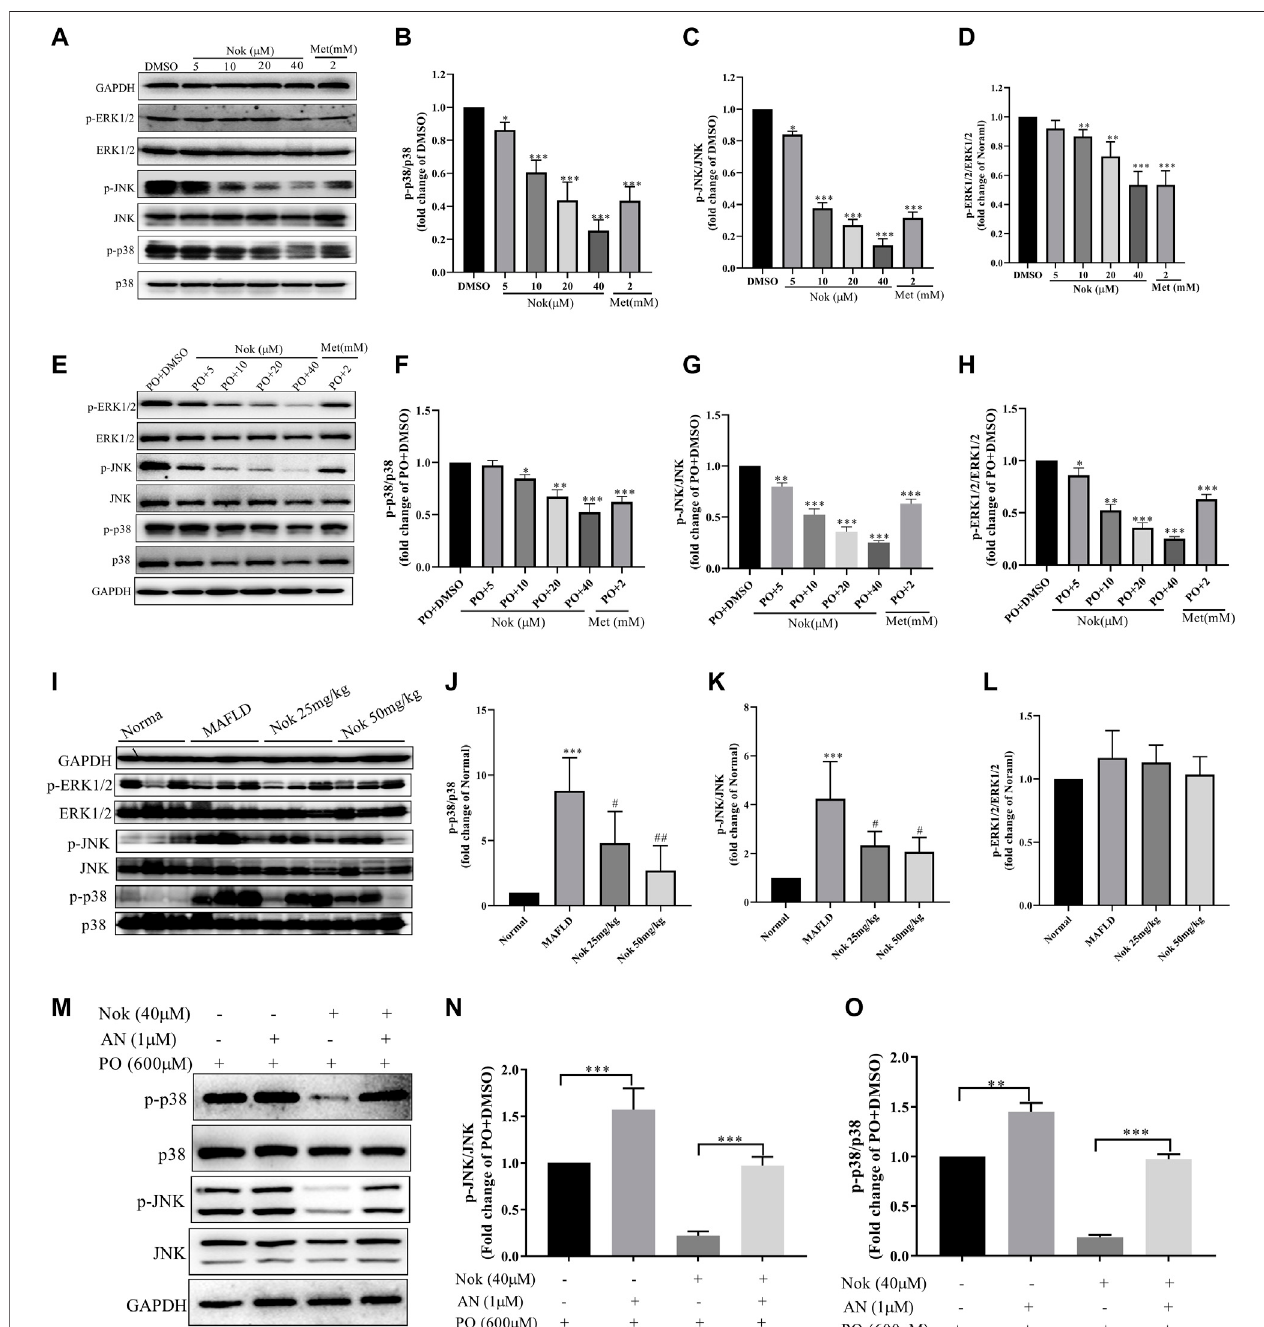
FIGURE 6 | Nok inhibited MAPK signaling pathways in vitro and in vivo . Total protein was extracted from the L02 cells after Nok treatment for 24 h. The levels of p-ERK1/2, ERK1/2, p-p38, p38, p-JNK, JNK and GAPDH were determined by western blotting. Representative blots for each sample are presented in (A) , and fold changesinp-p38/p38 (B) ,p-JNK/JNK (C) andp-ERK1/2/ERK1/2 (D) areshownbysemiquantitativeanalyses.Valuesarethemeans±SDfrom3separateexperiments, * p < 0.05, ** p < 0.01, *** p < 0.001 vs. DMSO. (E) Western blots were performed to analyze the phosphorylated and total protein levels of p38, JNK and ERK1/2 in L02cellswithNoktreatmentandundergoingPOinduction,andrepresentativewesternblotimagesareshownasabove.Thefoldchangesinp-p38/p38 (F) ,p-JNK/JNK (G) and p-ERK1/2/ERK1/2 (H) are shown by semiquantitative analyses. The values are the means ± SD from three separate experiments, * p < 0.05, ** p < 0.01, *** p < 0.001vs. PO+DMSO. After12weeksofNoktreatmentofC57BL/6JmicewithaHFD,totalprotein wasobtainedfromthemouse livers.Thelevels ofp-ERK1/2, ERK1/ 2,p-p38,p38,p-JNK,JNKandGAPDHweretestedbywesternblotting.Representativeblotsforeachgrouparepresentedin (I) .Foldchangesinp-p38/p38 (J) ,p-JNK/ JNK (K) and p-ERK1/2/ERK1/2 (L) were determined by semiquantitative analyses, and the values are expressed as the means ± SD (n = 6 per group). * p < 0.05, ** p < 0.01, *** p < 0.001 vs. Normal group mice # p < 0.05, ## p < 0.01, ### p < 0.001 vs. MAFLD model mice. (M) Inhibitory effect of anisomycin (AN, a JNK agonist) on Nok inhibitionofMAPKpathways,especiallytheJNKpathway.Representativewesternblotimagesareshownin(M),andfoldchangesinp-JNK/JNK (N) andp-p38/p38 (O) are shown by semiquantitative analyses, * p < 0.05, ** p < 0.01, *** p < 0.001.